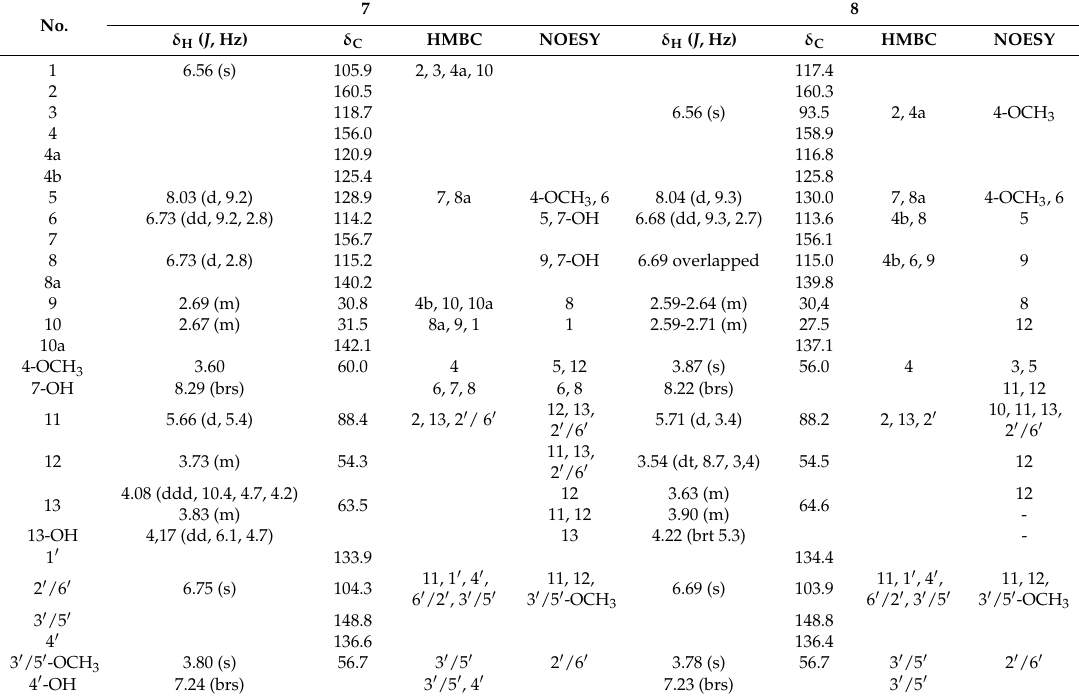
Table 4. 1 H (500MHz), 13 C (125 MHz), HMBC and NOESY spectroscopic data of compounds 7 – 8 ( δ in ppm, J in Hz) in acetone- d 6